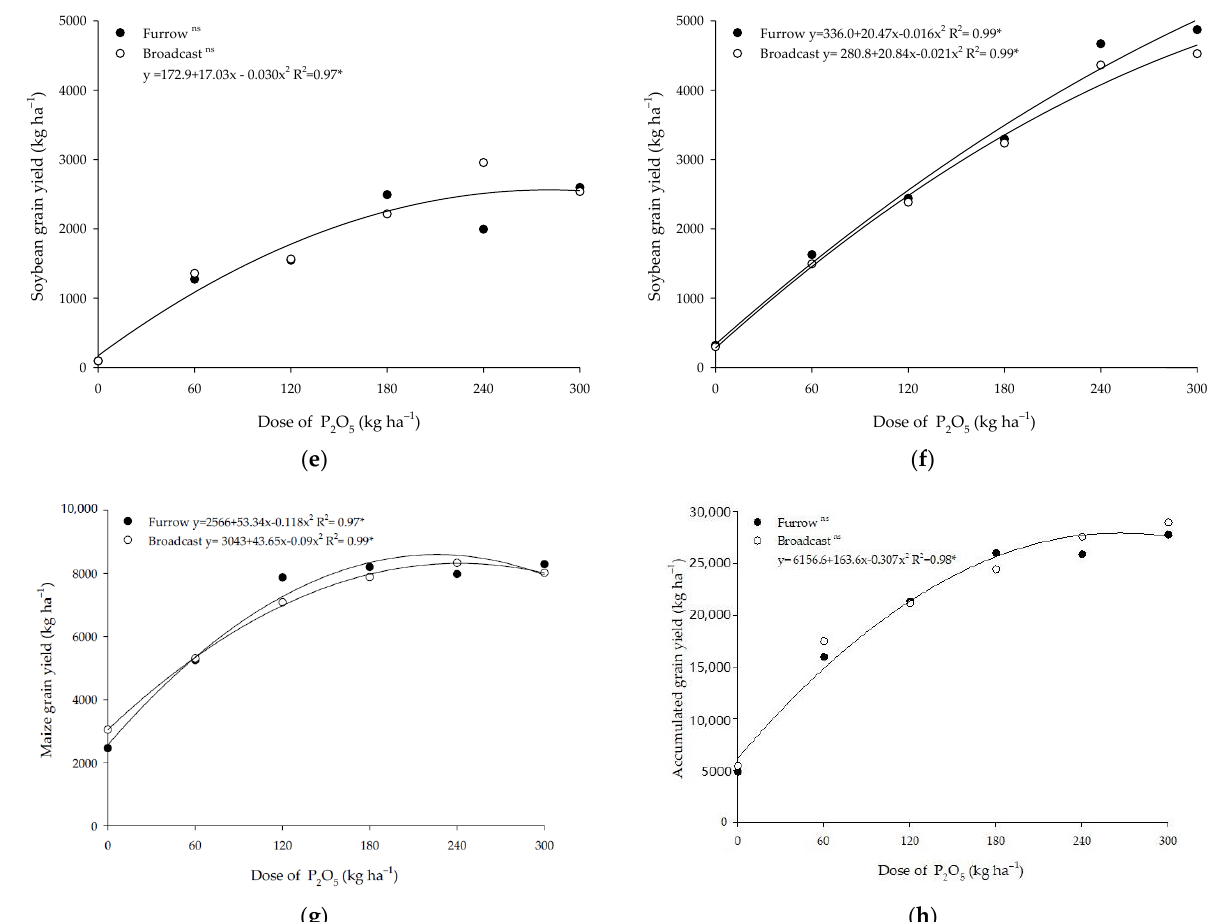
Figure 4. Grain yield of soybean in each annual season during six consecutive years, 2014/15 ( a ), 2015/16 ( b ), 2016/17 ( c ), 2017/18 ( d ), 2018/19 ( e ), 2019/20 ( f ), maize in 2019/20 season ( g ), and accumulated grain yield of soybean + maize ( h ) as a function of phosphate doses at seed furrow or broadcast. *: significant at 5%; ns: not significant. When considering the accumulated production, maximum grain yield should be obtained under 266 kg ha −1 of P 2 O 5 , regardless of the application mode (Figure 4h). Similar results were reported by Moreira et al. [27] in an opening Cerrado area (268 kg ha −1 of P 2 O 5 ), evaluating two seasons of soybean. Sousa and Lobato [28] observed the largest increments with P fertilizer doses between 60 and 280 kg ha −1 of P 2 O 5 . In addition, Fageria et al. [29] reported that the annual dose of 120 kg ha −1 of P 2 O 5 was the most responsive for grain yield when broadcasted without incorporation, although the authors did not evaluate higher doses than that. Carvalho et al. [30] observed maximum grain yield (average of two crop seasons) of the common bean under 239 kg ha −1 of P 2 O 5 in Mozambique (similar conditions of climate and soil as the Cerrado Region of Brazil). On the other hand, Mariussi et al. [31] verified that in soils with high fertility, soybean plants did not respond to P application (up to 280 kg ha −1 of P 2 O 5 ). In sugarcane, corrective (150 kg ha −1 P 2 O 5 broadcast and incorporated) and maintenance P (40 kg ha −1 P 2 O 5 per year) fertilization should be always considered due to the higher yield response over the cultivation cycles [32].